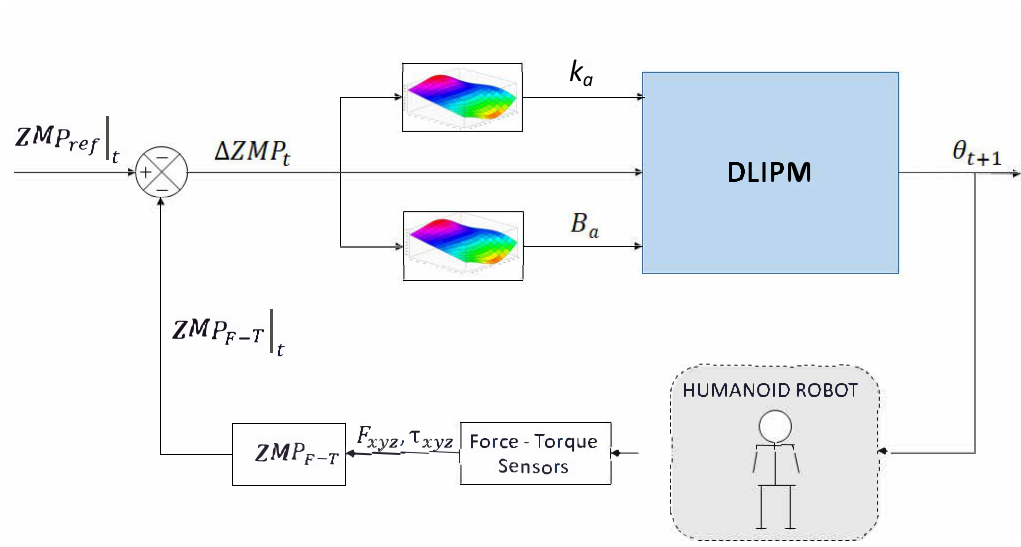
Figure 19. The TEO ZMP